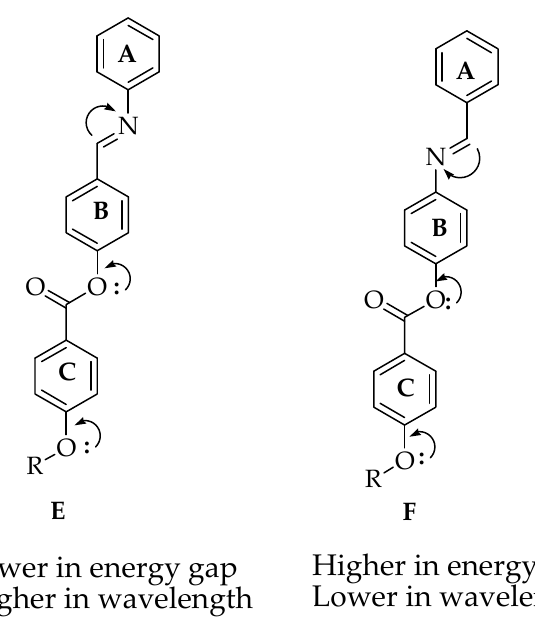
Figure 11. Resonance effect of compounds E, F. Table 4. Molecular orbital energies, hardness ( η ), and global softness ( S ) of compounds A – F. Compound